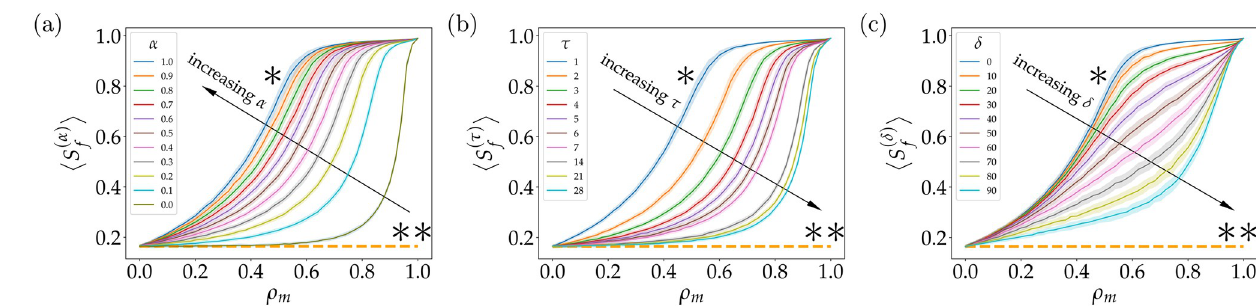
Fig 3. Accessing the effect of different communication strategies on the epidemic outcome. In all panels the final ratio of susceptible agents after 1000 days of simulation for different values of ρ . (a) Central information delivered to the population while the ratio of informed agents changes. Different m curves represent different ratios of informed agents α , ranging from 0 (olive line) to 1 (blue line) with 0.1 interval. (b) Periodicity of information delivery. Different curves represent different periodicity of information τ , delivered to the population. We have tested periodicity daily from 1 day (blue line) to 7 days (pink line), and then weekly, at 14, 21 and 28 days (green line). (c) Delay in starting information delivery. Different curves represent different delays δ , considering the elapsed time to deliver the message from the beginning of the epidemic. We have tested delay in the first message from 0 (blue line) to 90 days (light blue line) with 10 days interval. After the first message arrives, subsequent information is delivered daily. In all panels, shaded areas represent the standard deviation for 100 simulations. A � above blue line indicates the ideal strategy, and �� above orange dashed line indicates the worst strategy, i.e ., i where when there is no central information delivered to the population neither information delivered to infected agents. Curves with higher values of h S ð x Þ f x 2 { α , τ , δ } implied a better strategy result, i.e ., less infected